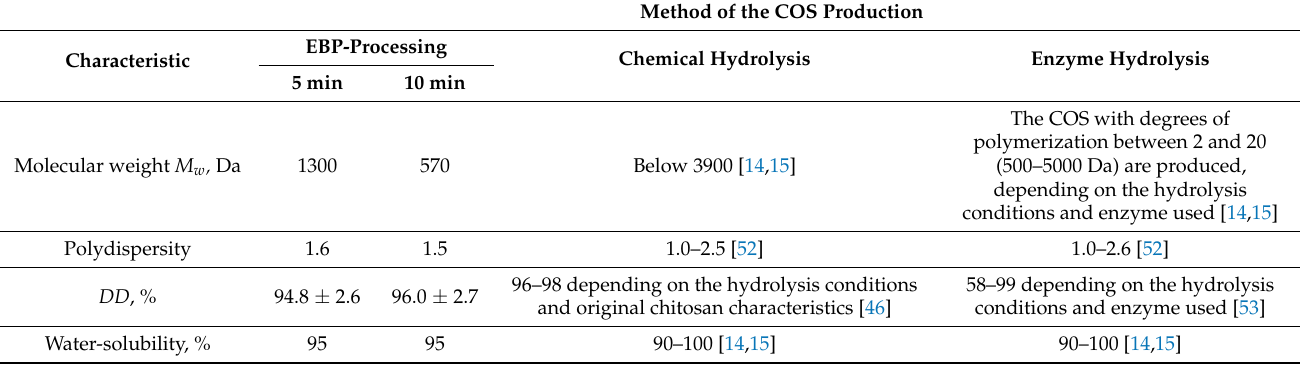
Table 2. Physicochemical properties of the COS obtained from chitosan by the EBP-processing and conventional